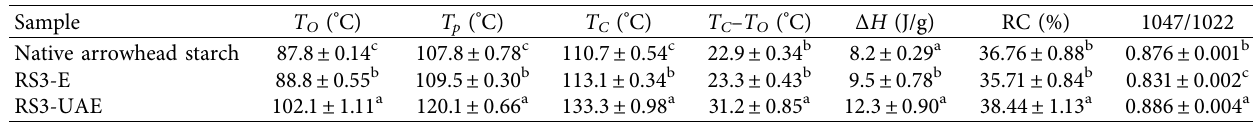
Table 2: Efects of ultrasound-assisted enzymolysis on thermal parameters, relative crystallinity (RC %), and the ratio of 1047/1022cm − 1 for native arrowhead starch, RS3-E, and RS3-UAE. RS3-E type 3 resistant starch prepared by traditional-enzymolysis; RS3-UAE type 3 resistant starch prepared by ultrasound-assisted enzymolysis.